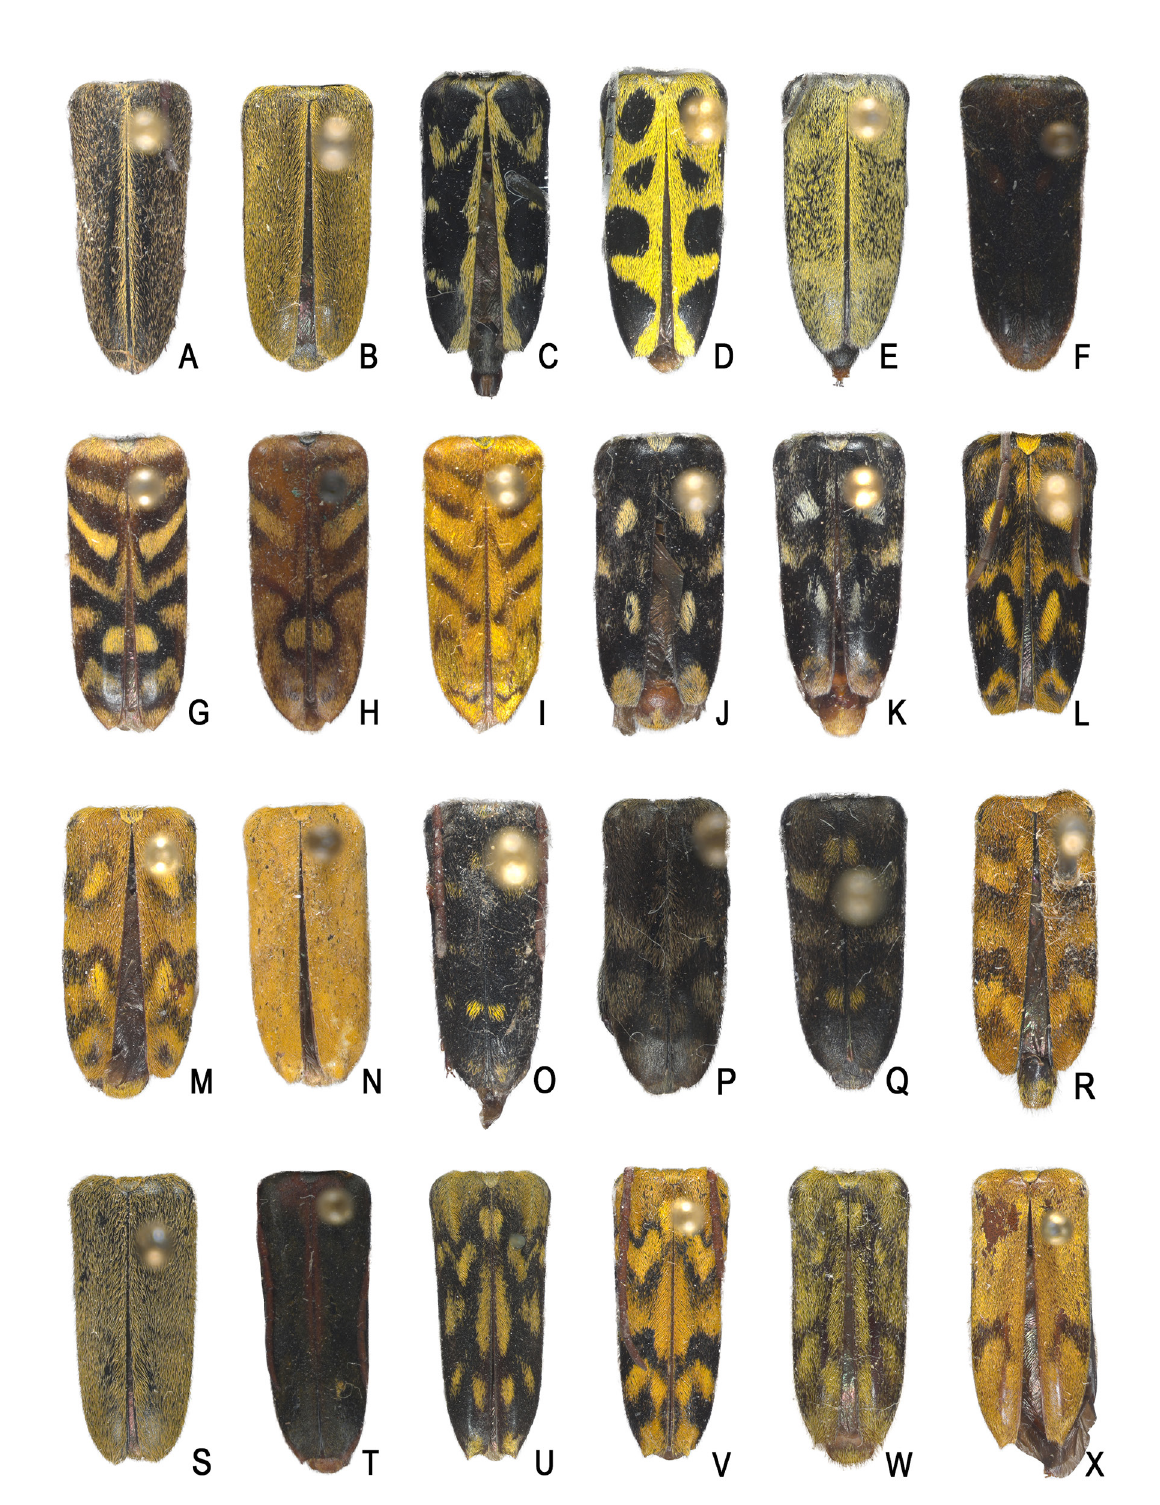
Fig. 3. Pubescence variation on the elytra in Ochraethes Chevrolat, 1860. A–B . Ochraethes brevicornis (Chevrolat, 1860) (♀, ♂). C–E . O . cinereolus (Bates, 1892) comb. nov. (♂, ♂, ♀). F–I . O . obliquus (Chevrolat, 1860) (♂, ♂, ♀, ♀). J–N . O . sommeri (Chevrolat, 1835) (♂, ♂, ♂, ♀, ♀). O–S . O . viridiventris (Chevrolat, 1860) (♂, ♀, ♂, ♂, ♀). T–X . O . z-littera (Chevrolat, 1860) (♂, ♂, ♂, ♀,